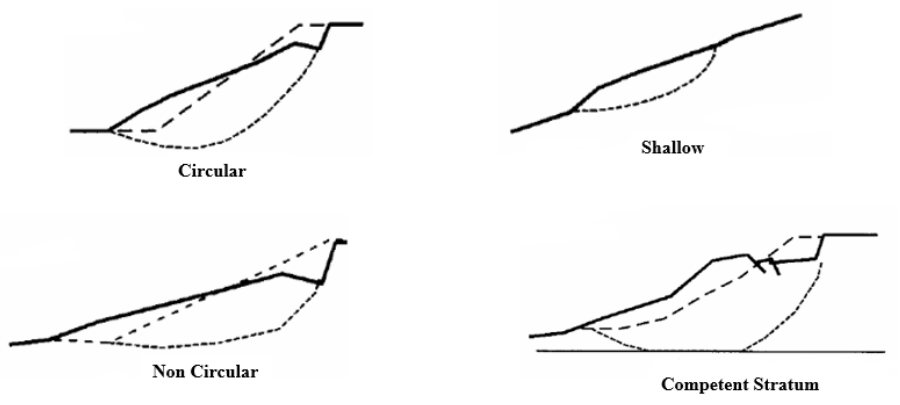
Figure 8. Mechanics of rotational and compound failure in rock slope (Adapted from [56]).